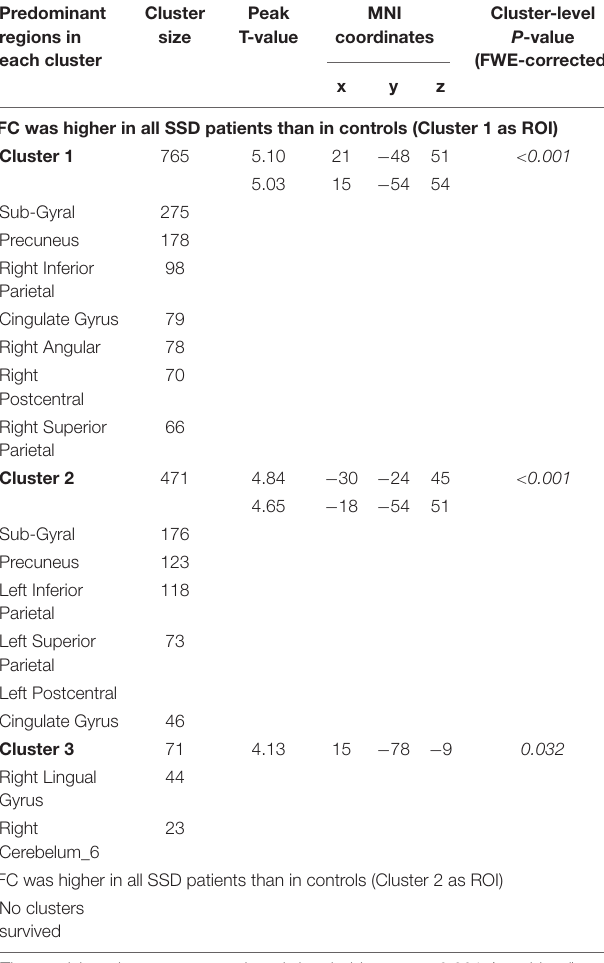
TABLE 3 | Significant inter-group differences in ROI-based FC